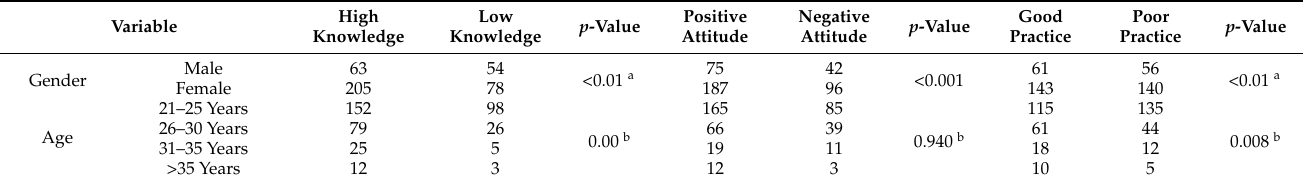
Table A1. Health Care Professionals (HCPs) knowledge, attitude, and practice scores regarding influenza vaccination against gender, age, education, profession, and job